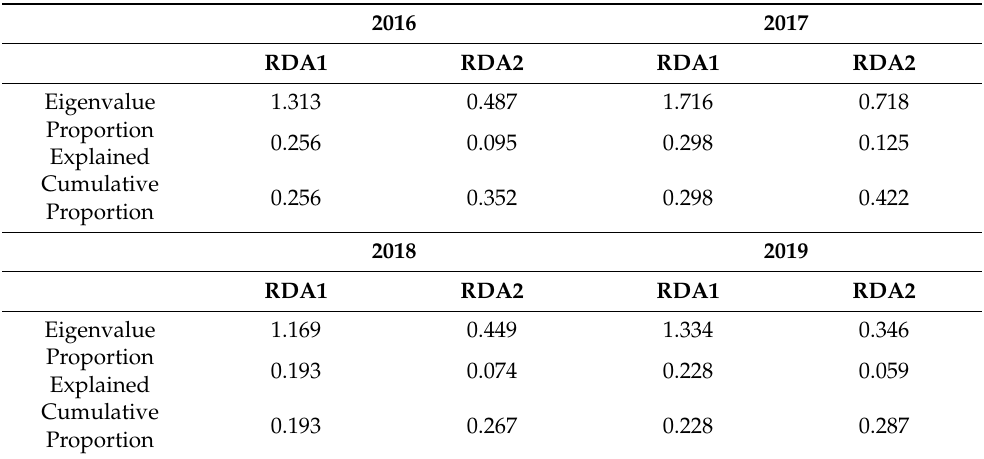
Table 2. Summary of RDA eigenvalues for the first two RDA axes for the amendment trial from 2016–2019.